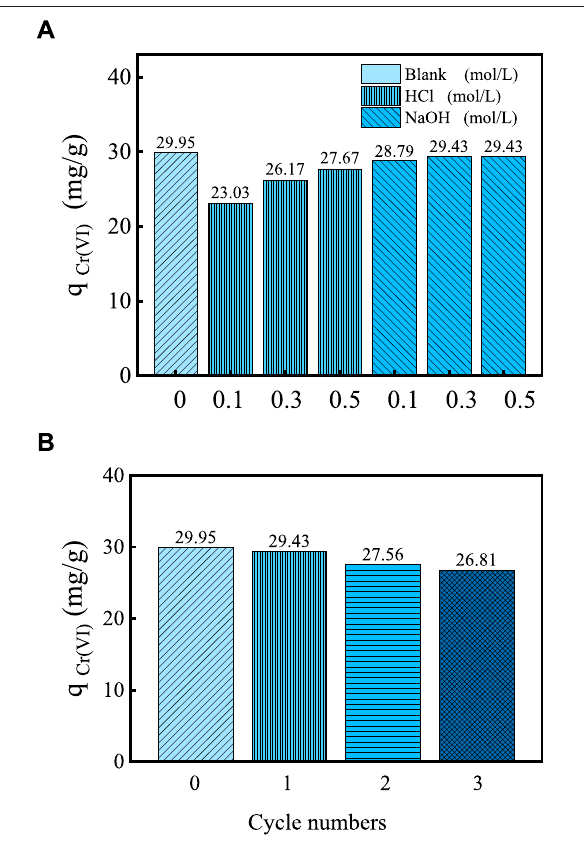
FIGURE 7 | Desorption and regeneration of Cr( Ⅵ ) sorption onto MBC- MFC. (MBC-MFC dosage (cid:1) 0.10 g/50 mL, C0 (Cr(VI)) (cid:1) 60 mg/L, T (cid:1) 25 °